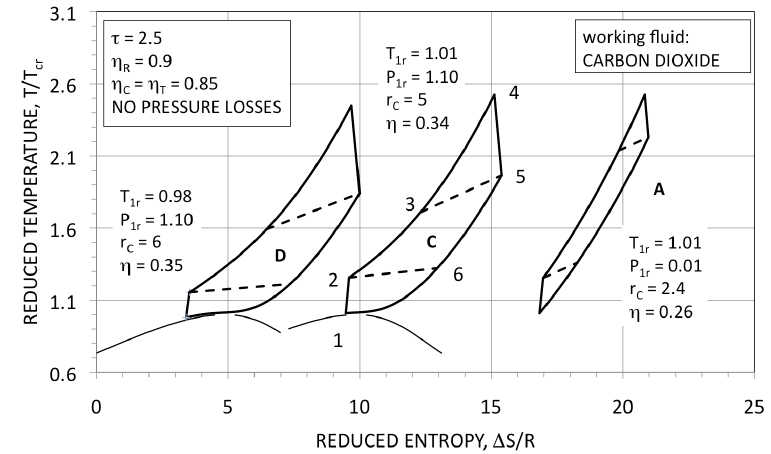
Figure 3. Some thermodynamic cycles in the reduced temperature–reduced entropy thermodynamic plane. Cycle A operates in the ideal gas region; cycles C and D are two real-gas Brayton cycles. The temperature T 1, r in cycle D is